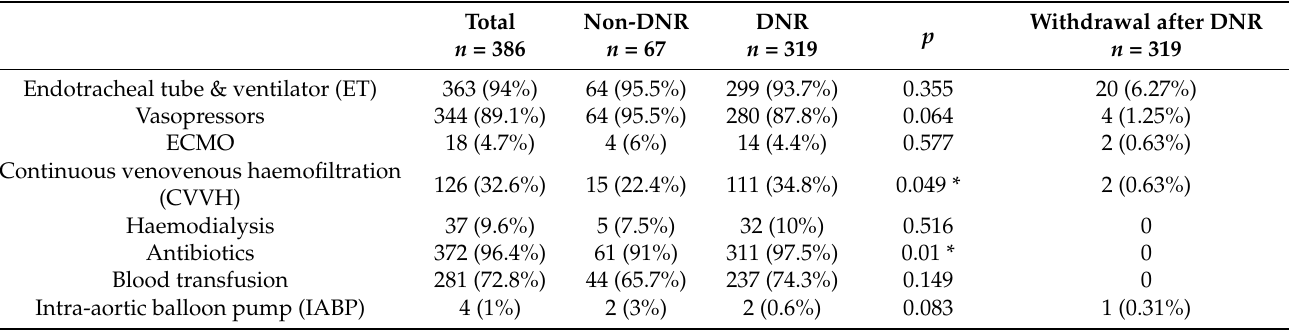
Table 4. Life-sustaining treatments were executed and withdrawn between the non-DNR group and the DNR